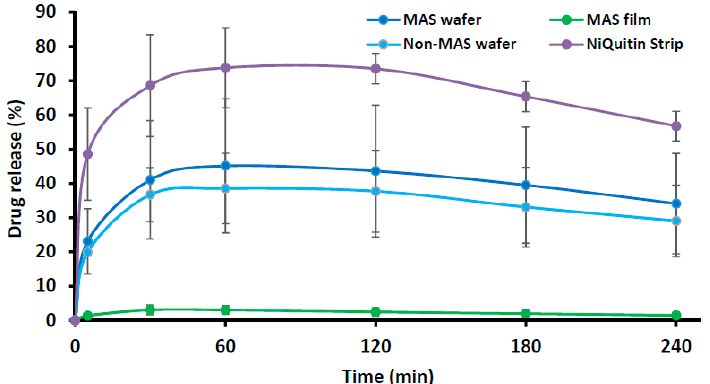
Figure 6. In vitro drug release profile of NiQuitin ® strip and HPMC/SA wafers and films ( n = 3, ± SD).